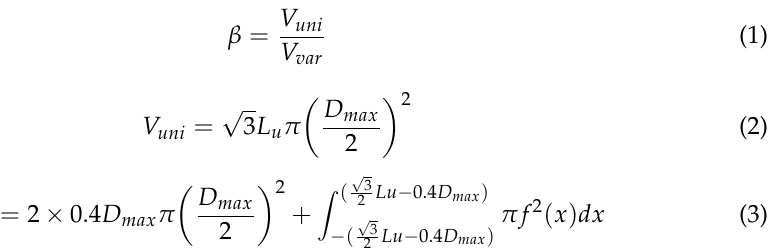
Figure 2. Bambusa-la tt ice structure inspired by bambusa joints and gradient tube walls: ( a – d ) Bam- busa joint and tube structures; and ( e ) Bambusa bionic design.